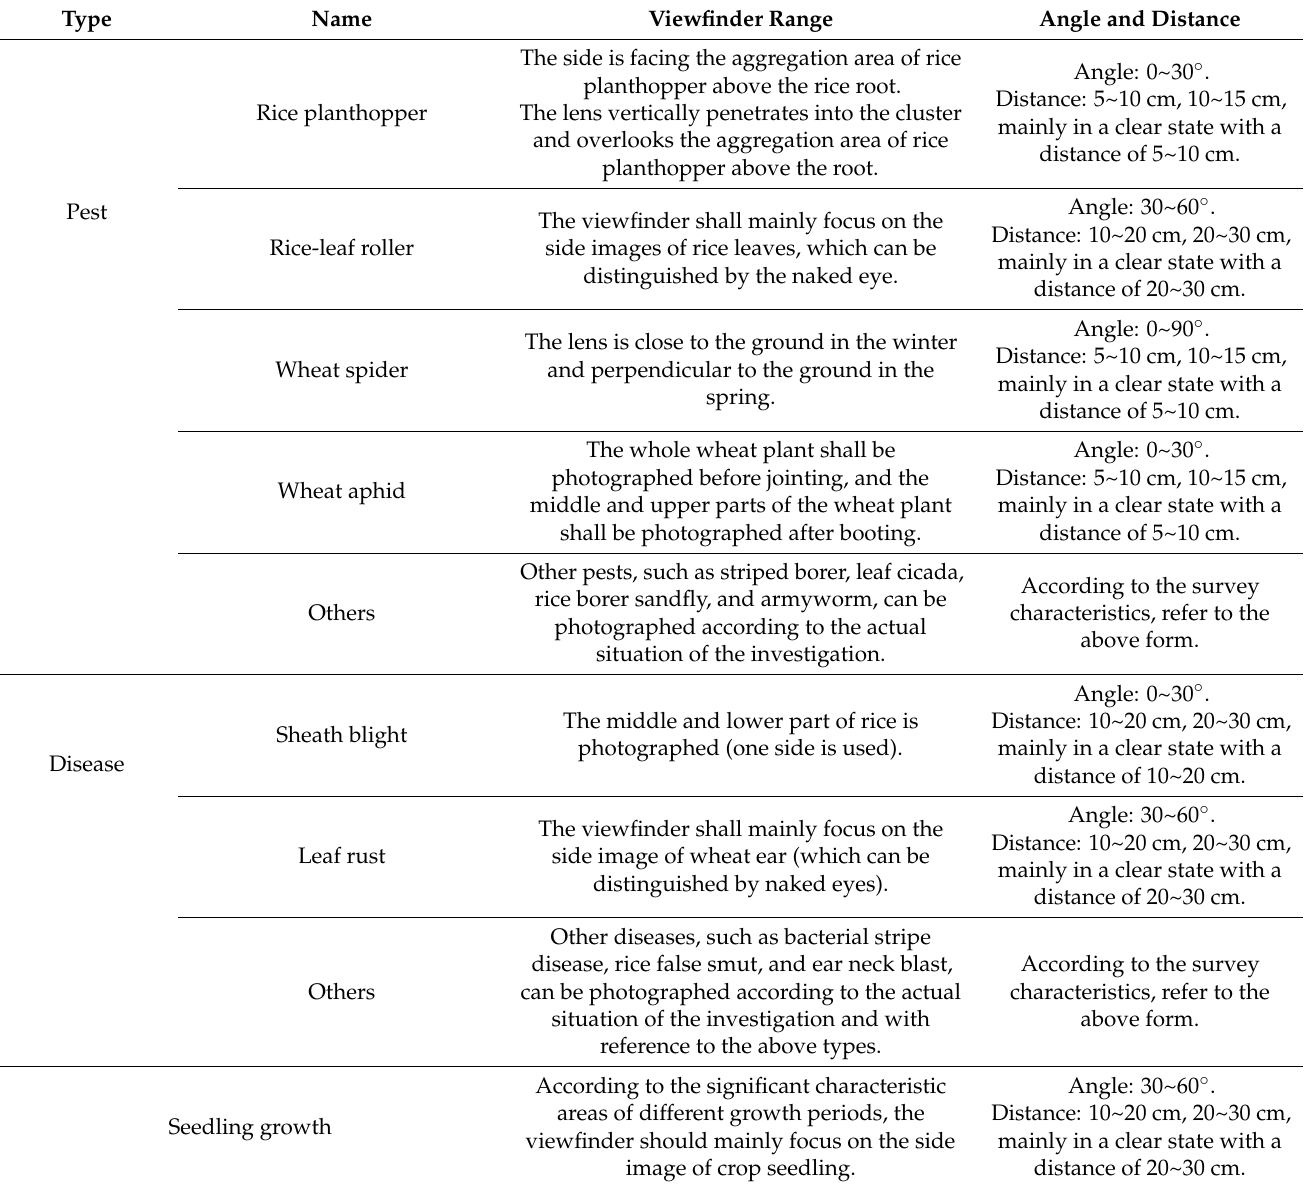
Table 3. Collection mode under different crops with diseases and